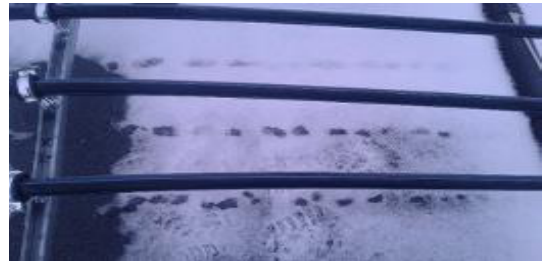
Figure 3. HDP pipes (collectors) on the roof in winter.